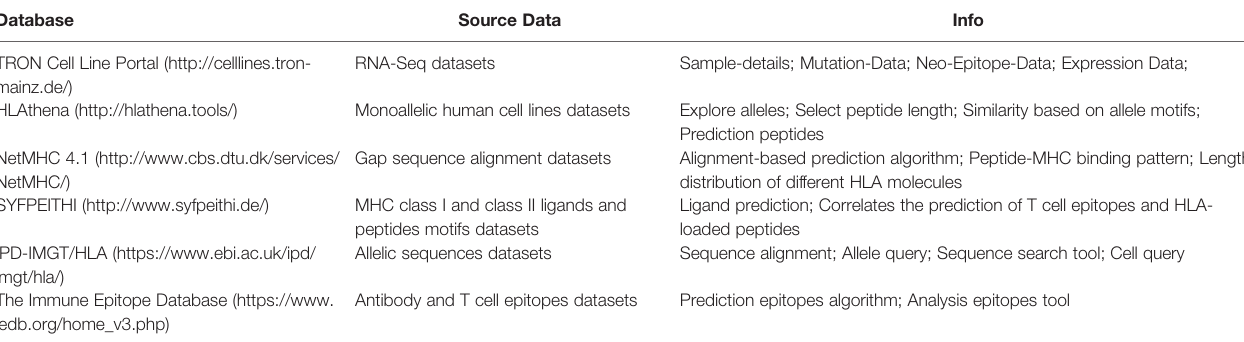
TABLE 1 | Main features related to current available databases focused on immunopeptidome characterization.